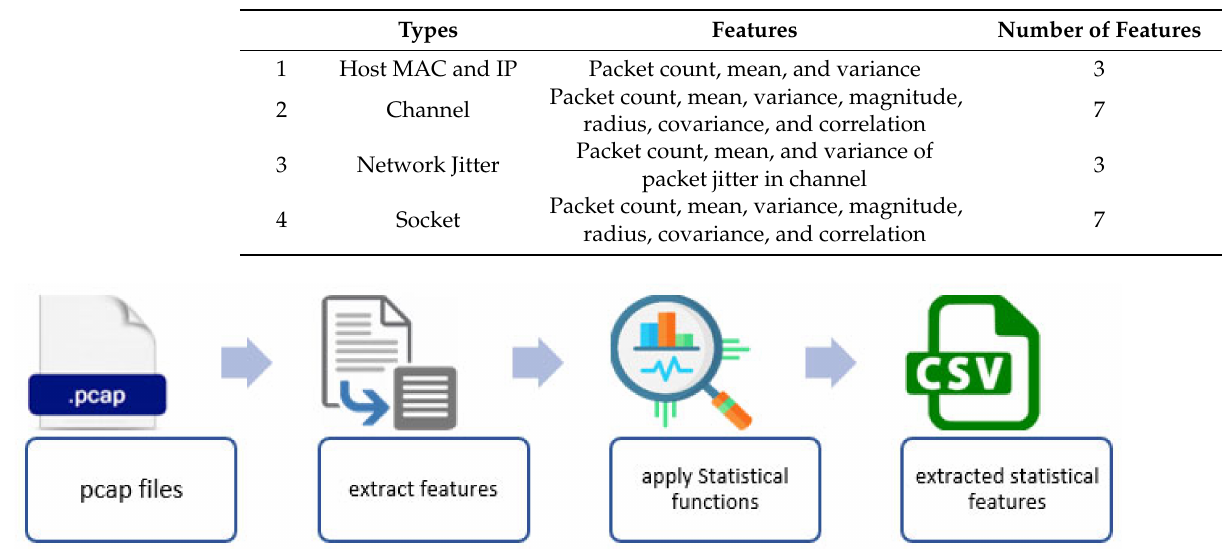
Table 4. Features in the dataset.